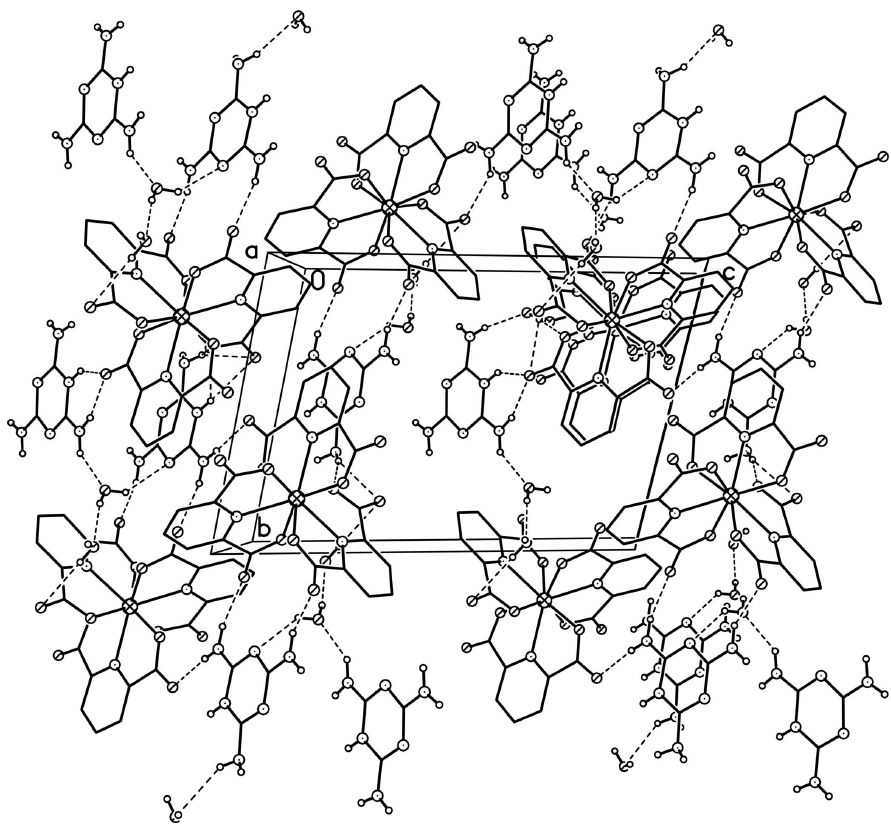
Crystal packing of the title compound along the crystallographic axis a. Hydrogen bonds are shown with dashed lines. Only the hydrogen atoms that take part in hydrogen bonding are